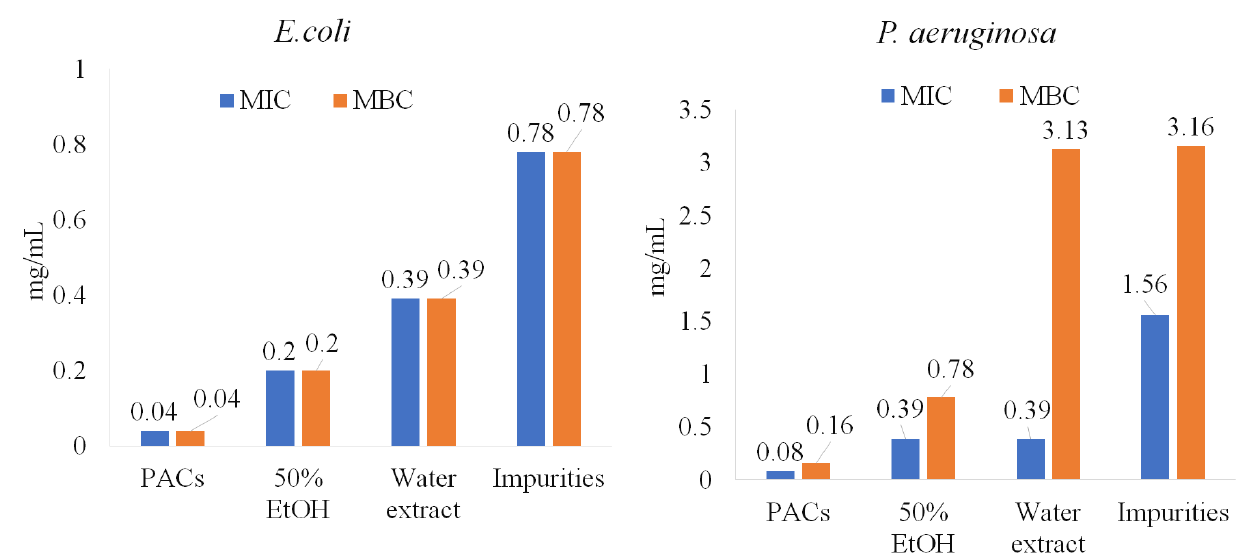
Figure 5. PACs’ role in anti-bacterial activity against E. coli and P. aeruginosa . Similar results were observed for P. aeruginosa , S. aureus , and B. cereus (Figure 6). Impurities were also tested and showed lower anti-bacterial activity potency, suggesting that PACs have a key role in inhibiting pathogenic bacteria.